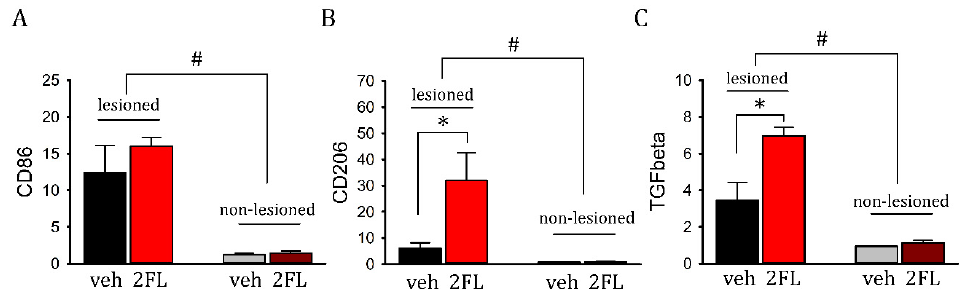
Figure 5. 2FL upregulated the expression of M2 markers in ICH brains. ICH significantly increased the expression of ( A ) M1 marker CD86, and M2 markers ( B ) CD206 and ( C ) TGF β ( # p = 0.005, two-way ANOVA). ( A ) 2FL significantly upregulated the expression of ( B ) CD206 and ( C ) TGF β , but not ( A ) CD86, in the lesioned striatum (* p < 0.05, NK test).